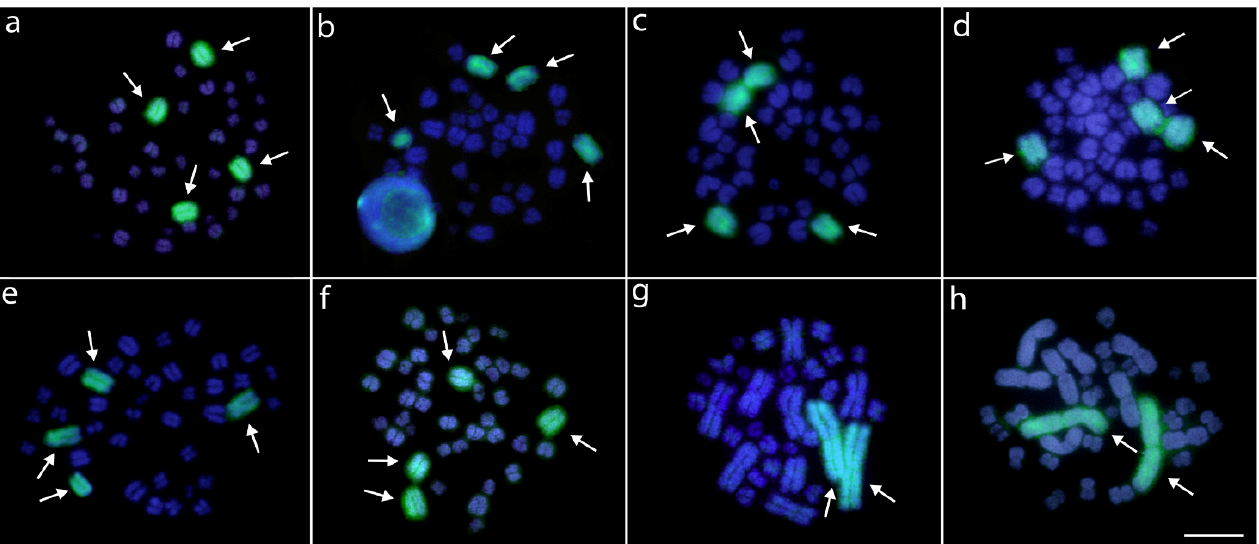
Figure 5. Metaphase chromosomes from females Caiman crocodilus ( a ), C. latirostris ( b ), C. yacare ( c ), Melanosuchus niger ( d ), Paleosuchus palpebrosus ( e ), P. trigonatus ( f ), Alligator mississippiensis ( g ), and A. sinensis ( h ) hybridized with (CGG) n mi- crosatellite probe (red). Chromosomes were counterstained with DAPI (blue). Arrows indicate the CGG+ signals. Bar = 20 µm.